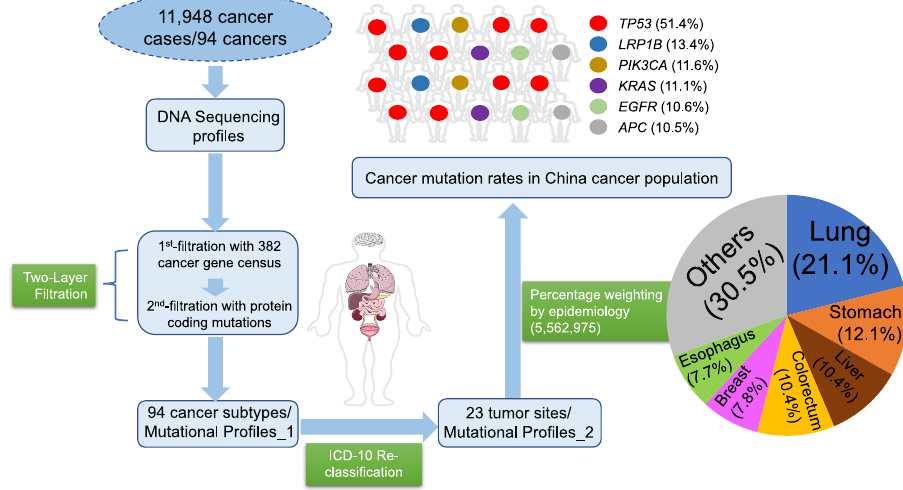
Fig. 1 | Work fl ow of current study. The work fl ow for calculating epidemiologically weighted cancer gene mutation proportions within the Chinese cancer population. Source data are provided as a Source Data